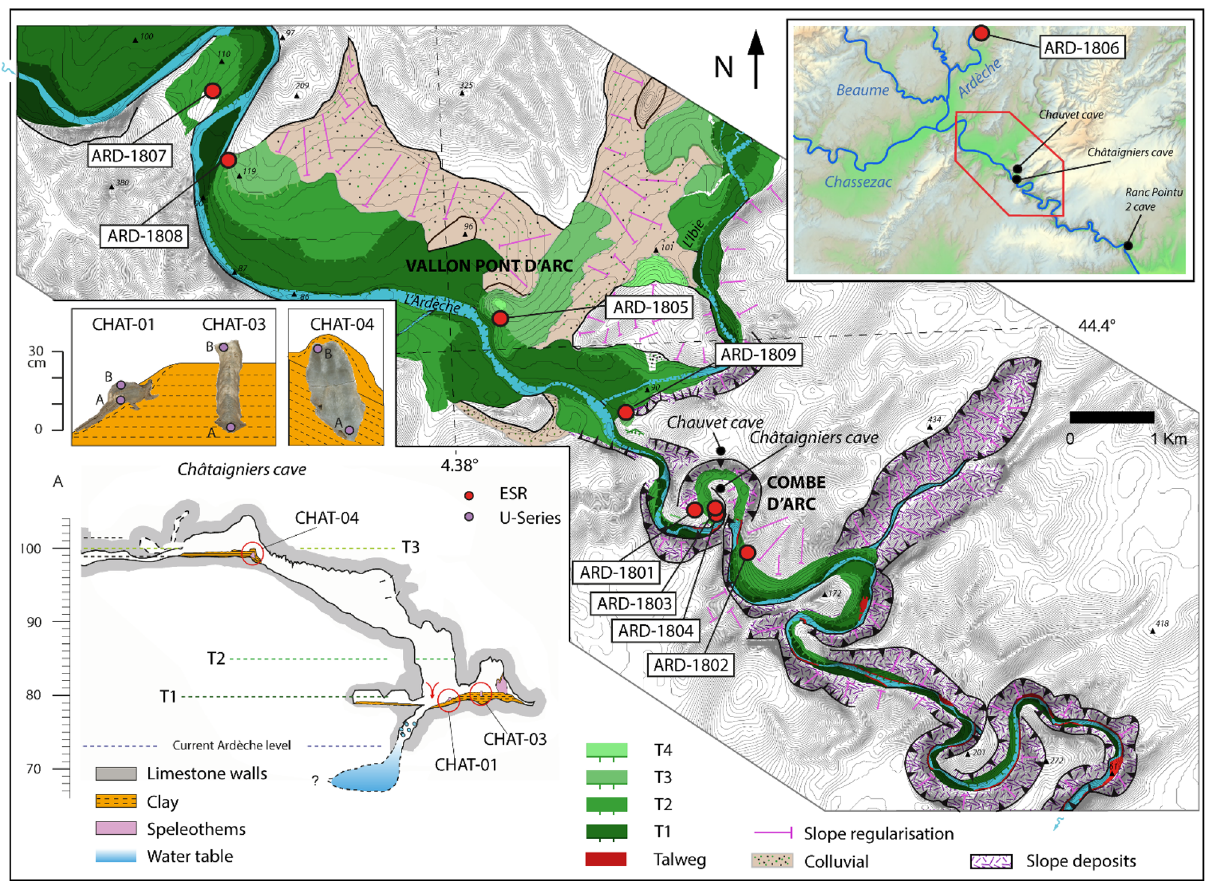
are reported in the Supplementary Fig. S2). The T1, T2 and T3 altitudes are reported on the Châtaigniers cave topography for comparison with the speleothem and clay deposits location. Geomorphological map from 19 , modified. Speleothem photographs from: Kim